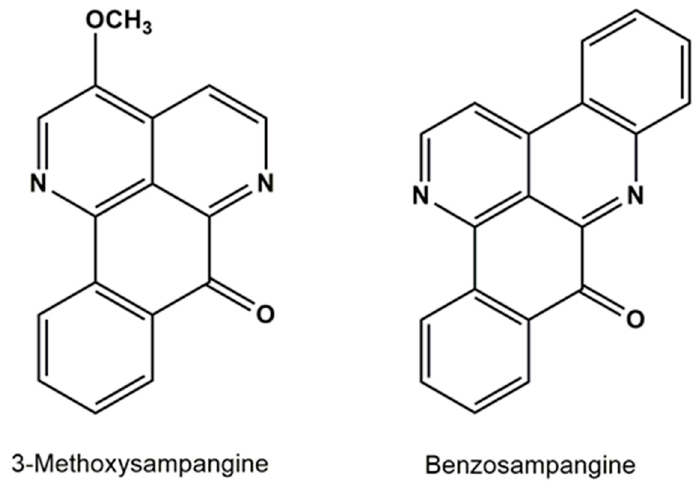
Figure 9. Chemical structure of 3-methoxysampangine and benzosampangine.